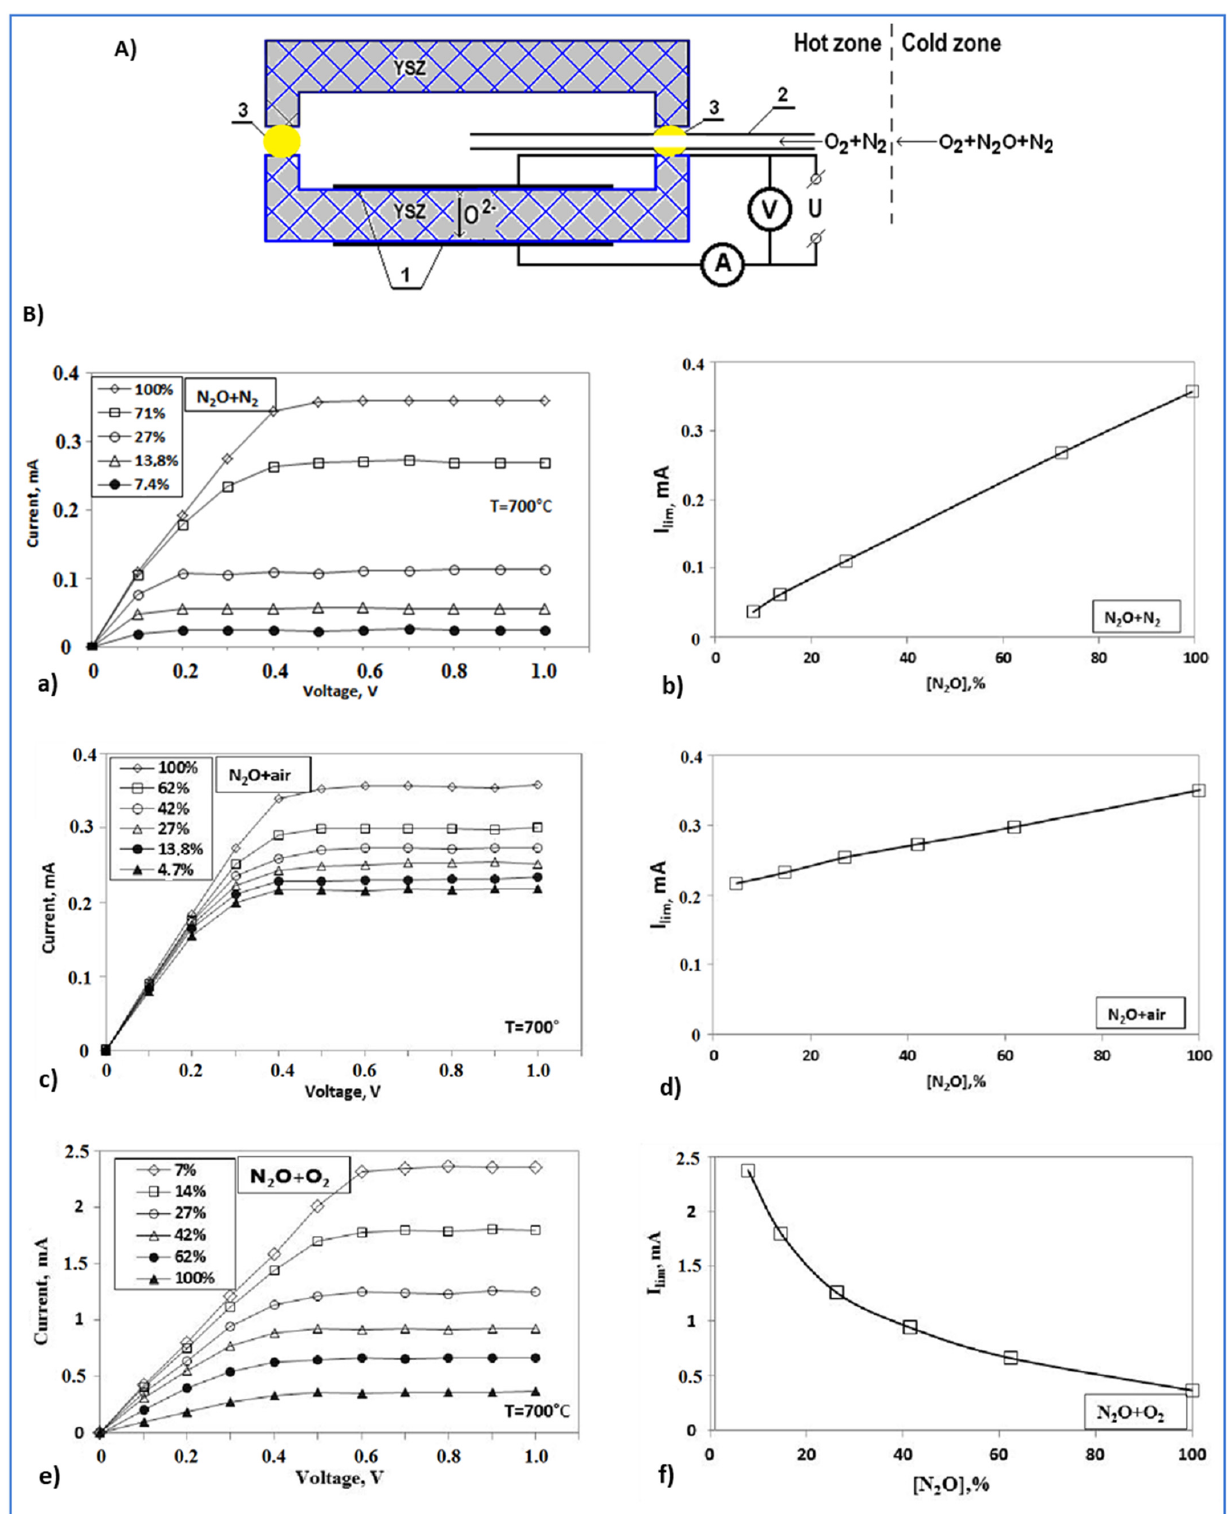
Figure 5. ( A ) A scheme of an amperometric NO x sensor. (1) Pt electrodes, (2) capillary, and (3) glass sealants. Reproduced with permission from [58]. ( B ) Current–voltage curves at 700 °C for different N 2 O concentrations in mixtures of ( a ) N 2 O +